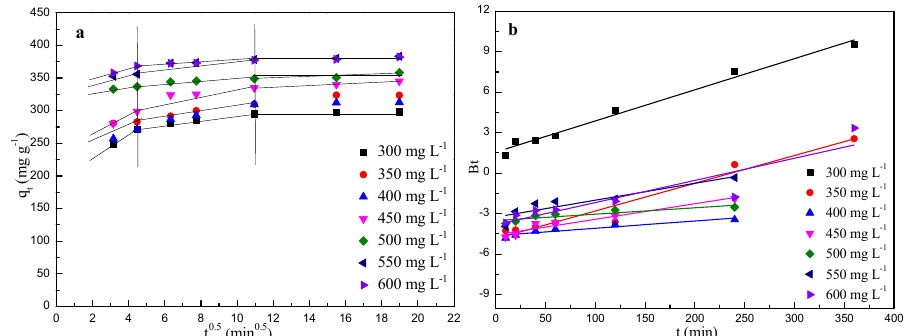
Figure 10. Plots of ( a ) intra-particle diffusion model and ( b ) Boyd model for the adsorption of MB on BSNC-800-4 at 298 K.